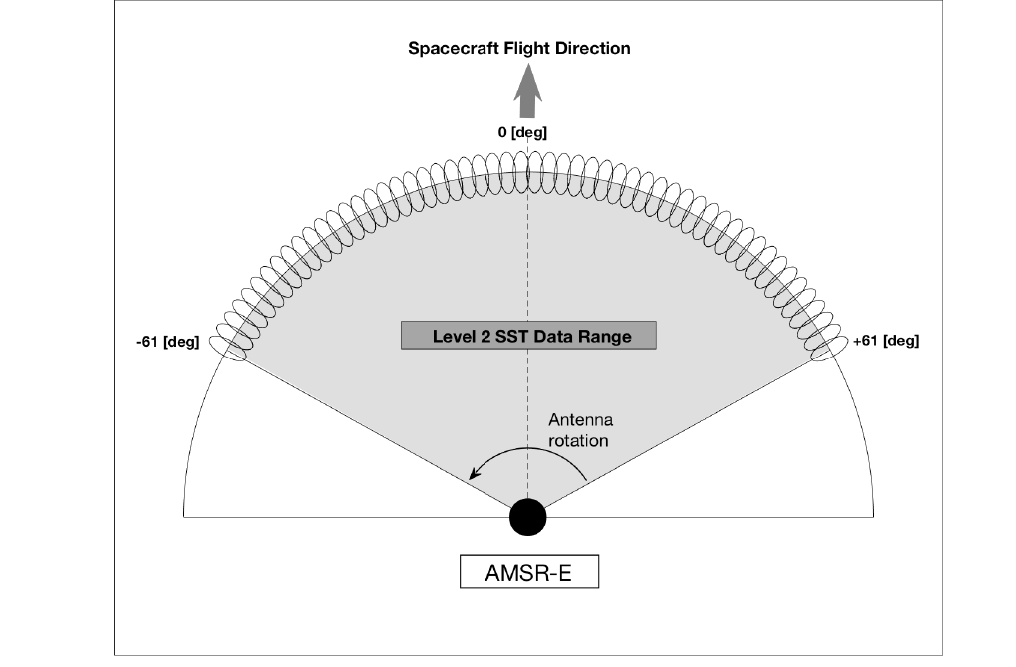
Figure 1. The scan geometry of the Advanced Microwave Scanning Radiometer-Earth observing satellite (EOS) (AMSR-E). The ellipses schematically illustrate the AMSR-E footprint. Errors in the AMSR-E SST retrievals resulted primarily from scattering due to rain, sidelobe contamination due to proximity to land and/or sea ice, radio frequency interference (RFI), sunglint, wind speed > 20 m/s, and proximity to the edge of the swath. Data flagged for any of these conditions were excluded from the